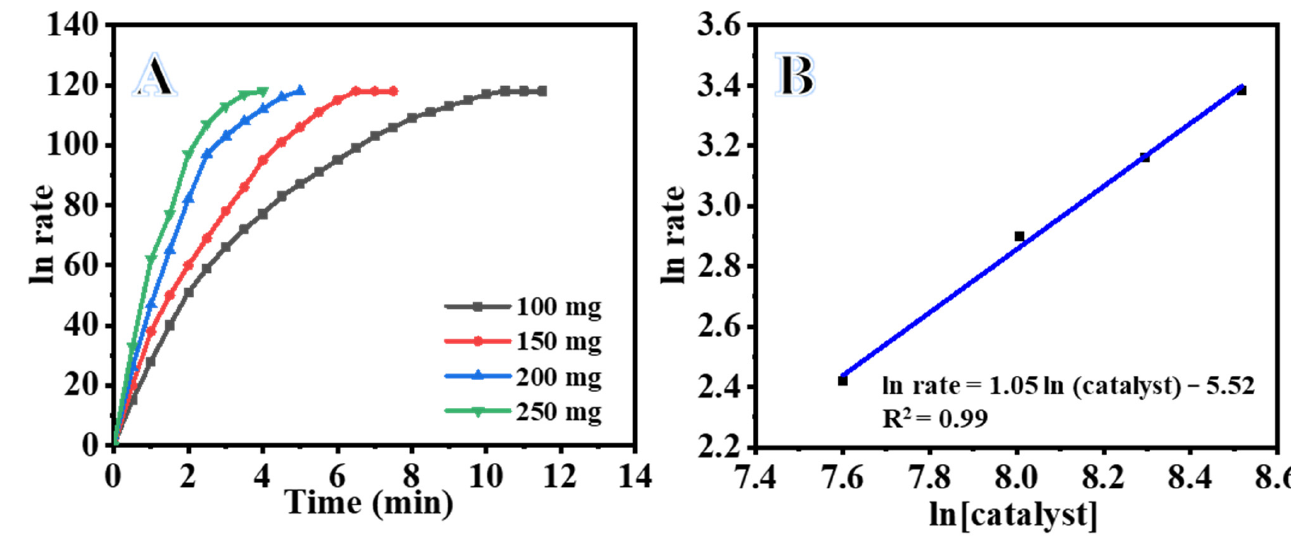
Figure 7. Effect of Ni 0.3 Co 0.7 @PVDF ‐ co ‐ HFP NFs on the dehydrogenation of SBH ( A ) and the log of the H 2 generation rate vs. log of catalyst quantity ( B ). ([SBH] = 1 mmol and T = 298 K).